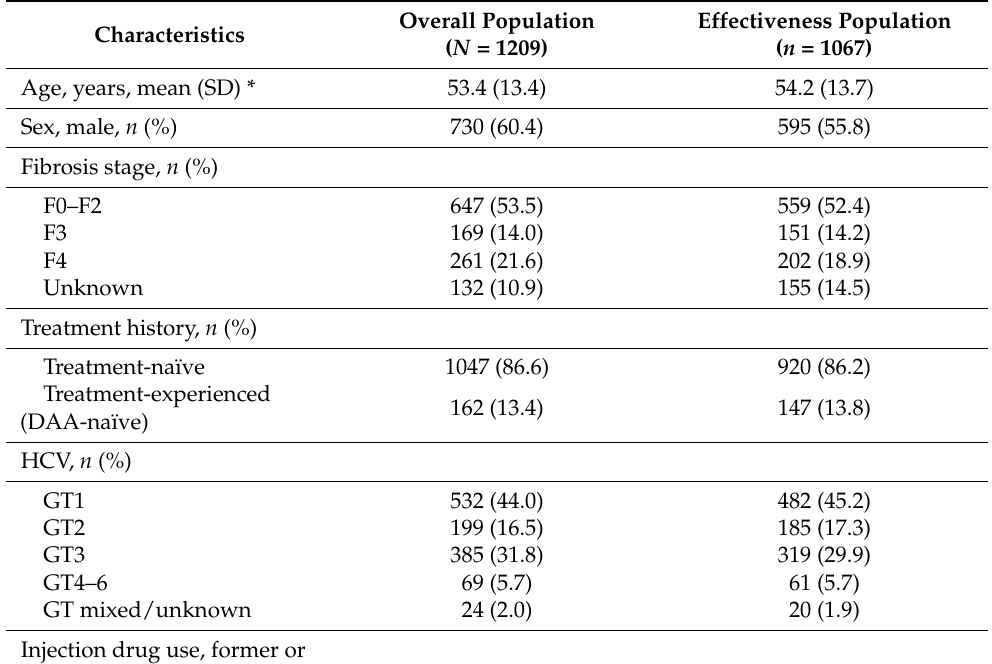
Figure 1. Flowchart of patients included in this real-world analysis. Effectiveness population includes all patients with a valid SVR12/24 result available. Abbreviations: LTFU: loss to follow up; SVR: sustained virological response. Table 1. Baseline demographics and clinical